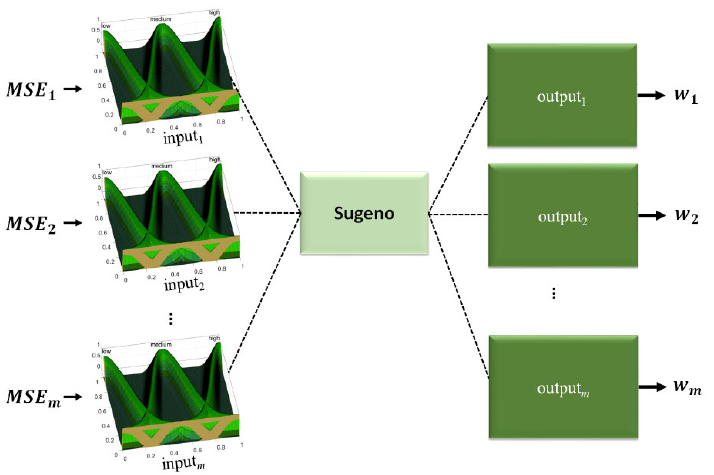
Figure 6. Sugeno type ‐ 3 FIS model.